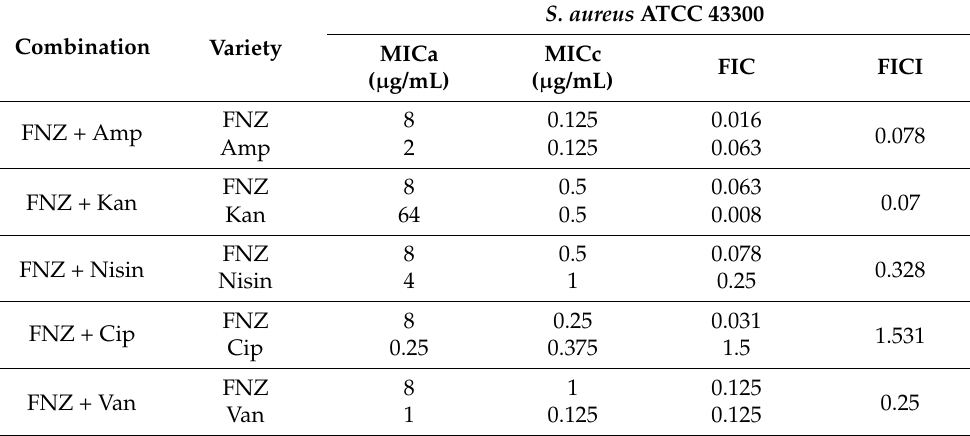
Table 2. Combination effects of FNZ with antibiotics against S . aureus ATCC